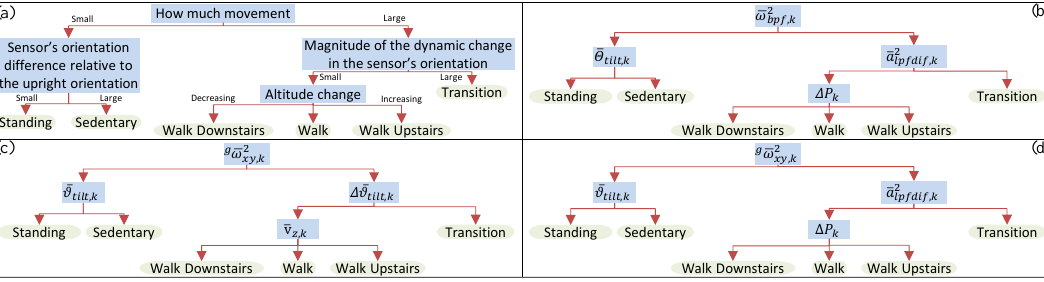
Figure 4. Illustration of how the activity classes can be separated using ( a ) a hierarchical description of human activity. A schematic for achieving the separation using the following features: ( b ) only original (i.e., features (1)–(4)), ( c ) only new (i.e., features (5)–(8)), and ( d ) best features from all eight old and New Features (i.e., features (3)–(6)) in Table 2. Each blue rectangle represents a classification and regression tree (CART) [73] implemented in MATLAB 2013b with ‘ClassificationTree.fit’. The CART algorithm used ‘uniform’ prior class probabilities to ensure that the thresholds selected accounted for any class imbalances.